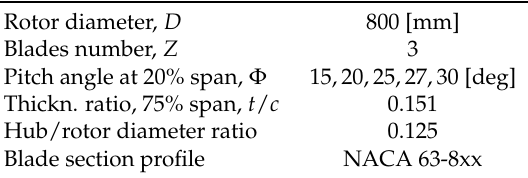
Table 2. UoS-VP turbine geometry parameters.